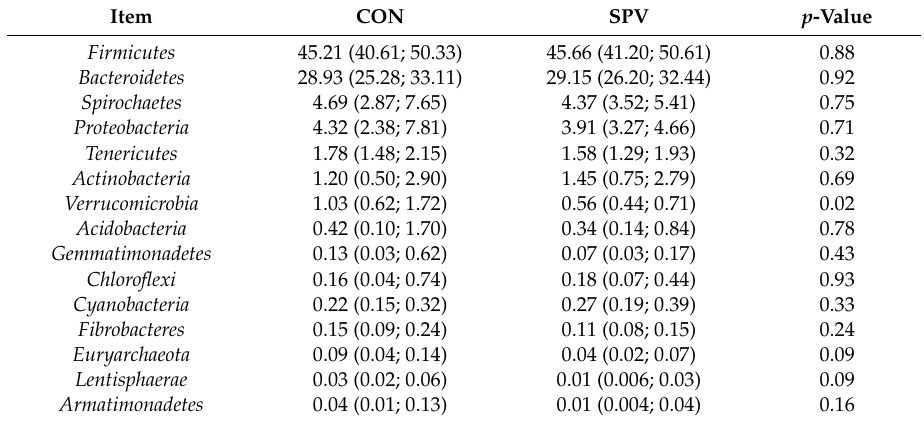
Figure 6. 16S rRNA gene analysis reveals phyla ( A ) and genus ( B ) level di ff erences between the treatments. CON, gilts feed the basal diet; SPV, gilts fed basal diet with sweet potato vine. Table 6. The e ff ect of sweet potato vine treatment on the relative abundances of fifteen phyla (%, ≥ 0.01% of total abundances) in Meishan gilts.